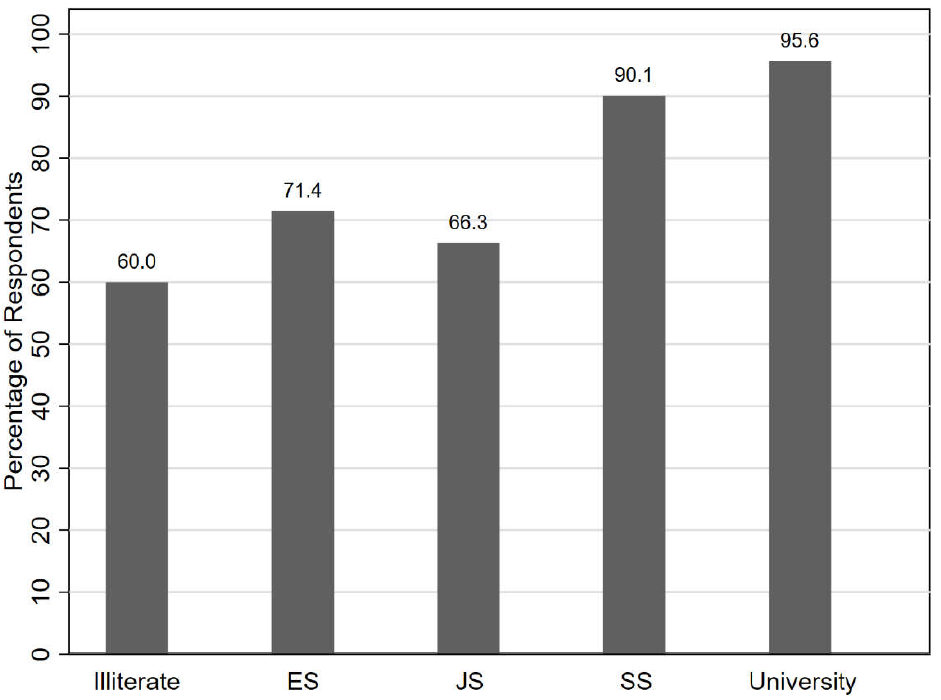
Figure 1. Percentage of respondents who have heard of zoonotic diseases by education